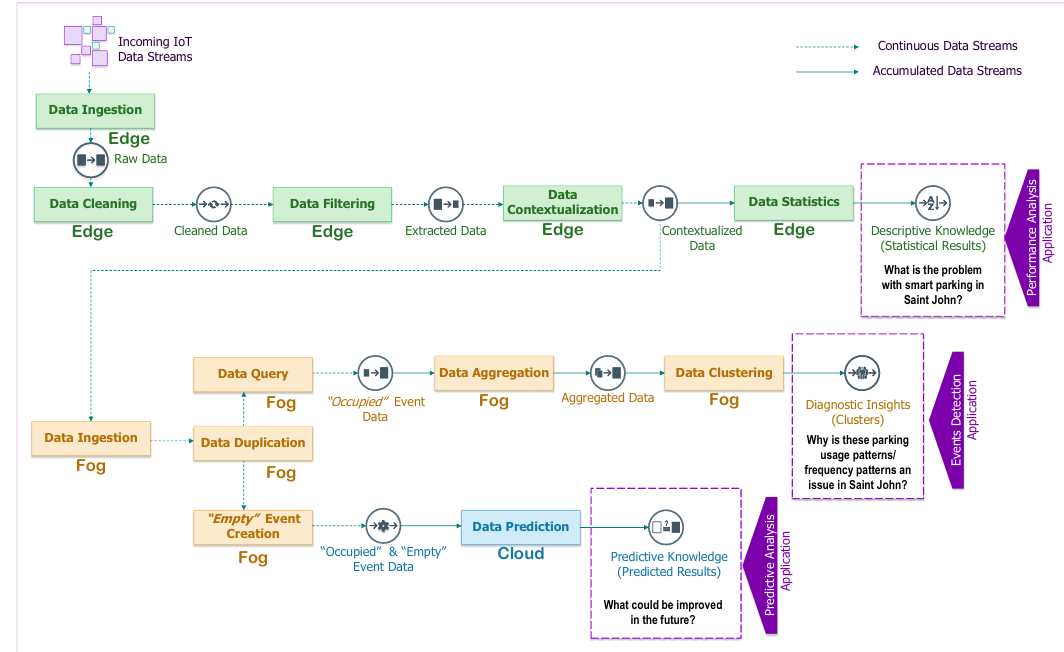
Figure 5. Overview of the implemented data